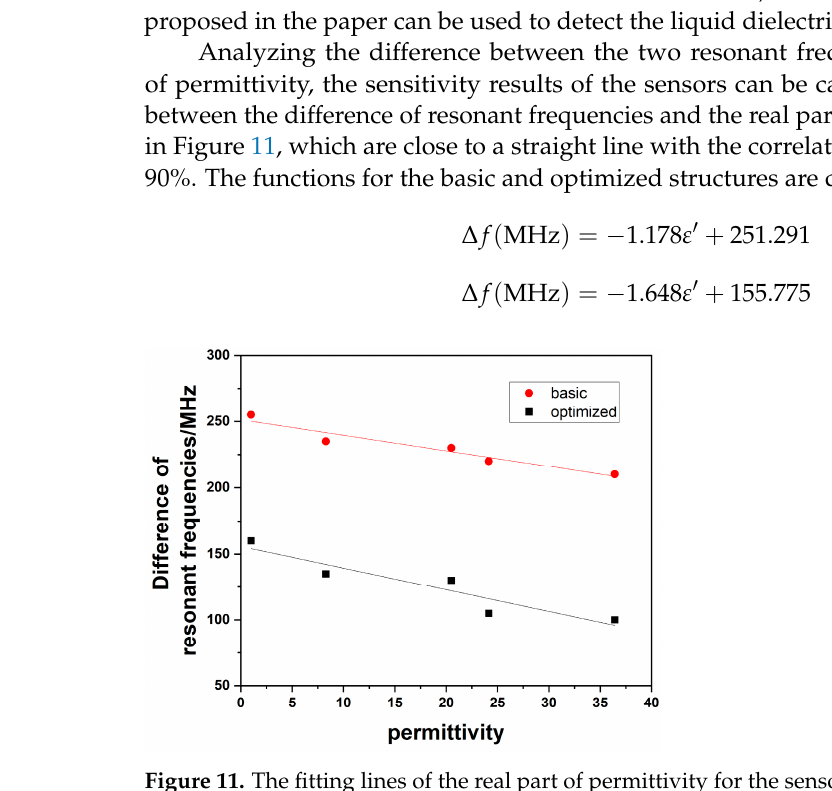
Figure 11. The fitting lines of the real part of permittivity for the sensors.